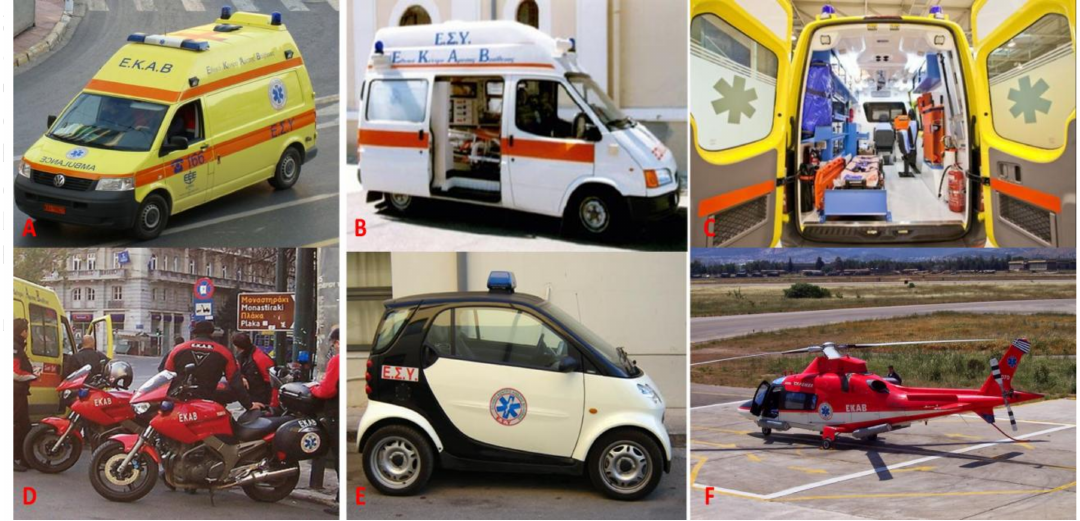
Figure 2. Types of EKAB ambulances. ( A , B ) Basic type of Ambulance; ( C ) Mobile Intensive Care Units; ( D ) Motorcycle ambulances; ( E ) Small vehicles for minor roads; ( F )